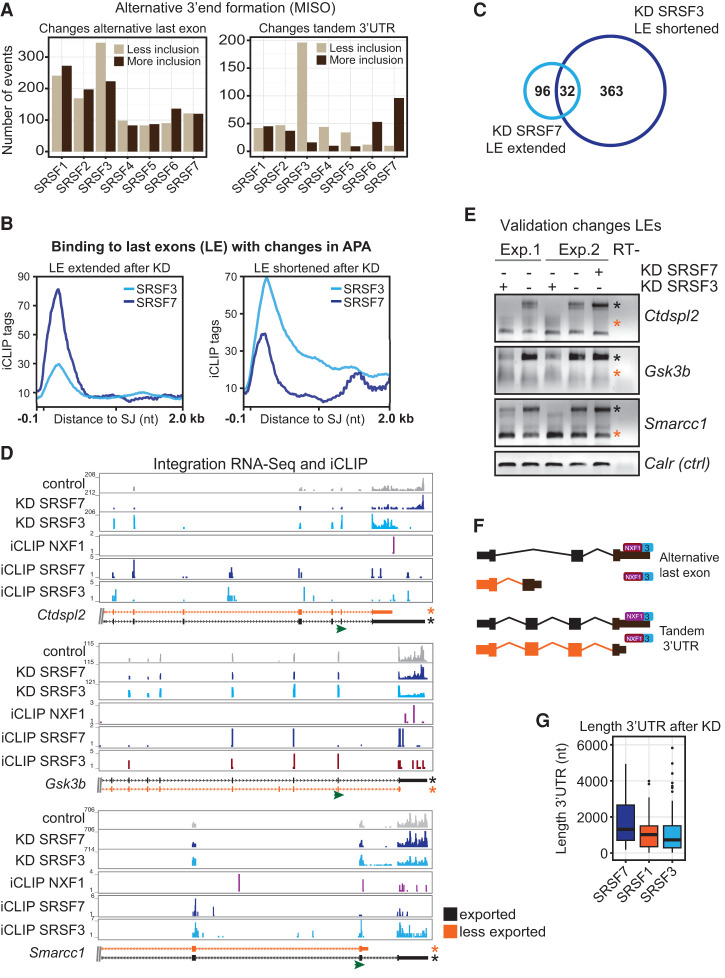
SRSF3 and SRSF7 regulate 3′ UTR length in an antagonistic manner and link alternative 3′ end formation to mRNA export. (A) Changes in last exon usage in cytoplasmic samples were mapped to annotated splicing events (ALE and TandemUTR) using MISO (Katz et al. 2010). BF > 5; 20% change. (B) Profiles of significant cross-link sites of SRSF3 and SRSF7 in last exons undergoing APA after depletion of the cognate SR protein. (C) Venn diagram. Thirty-two genes are regulated in an antagonistic manner by SRSF3 and SRSF7 in APA (cutoff FDR < 0.1). (D) Transcripts chosen for validation. Browser shots including affected isoforms (ENSEMBL); RNA-seq read coverage of control RNAi (gray), SRSF3 RNAi (light blue), and SRSF7 RNAi (dark blue); and significant cross-link sites of SRSF3 (light blue), SRSF7 (dark blue), and NXF1 (purple). The transcript isoforms shown are truncated. (Green arrow) Gene-specific forward primer in the penultimate exon for rapid amplification of cDNA 3′ end (3′RACE) RT–PCRs. (E) Validation of APA changes after knockdown (KD) of SRSF3 and SRSF7 by 3′RACE RT–PCR. Orange and black asterisks indicate the transcript isoforms shown in D. (F) Model of how SRSF3 and SRSF7 binding in last exons may affect APA, NXF1 binding, and mRNA export in a splicing-dependent and -independent manner. (G) Length distribution of 3′ UTRs from transcripts, which decrease in cytoplasmic abundance after depletion of SRSF7, SRSF1, and SRSF3.